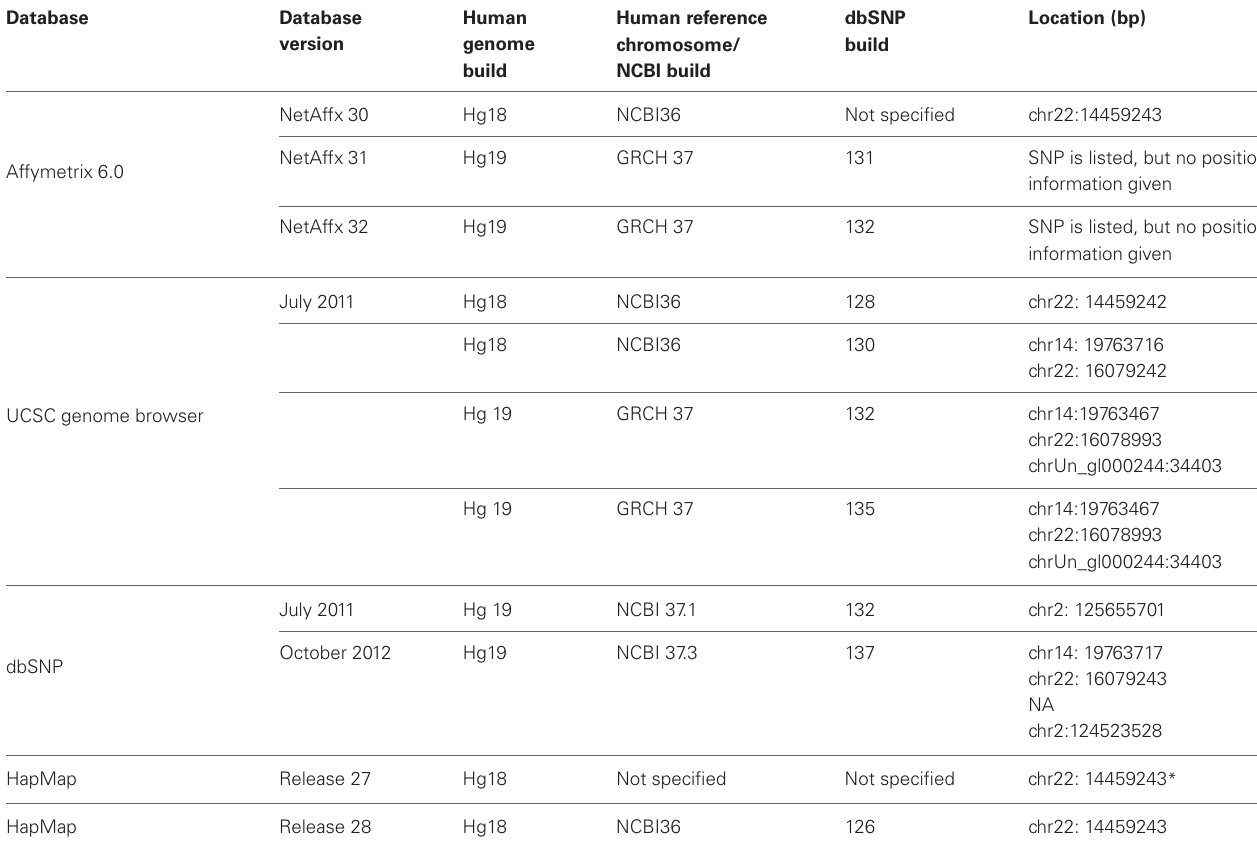
Table 2 | Discrepancies in the location of SNP